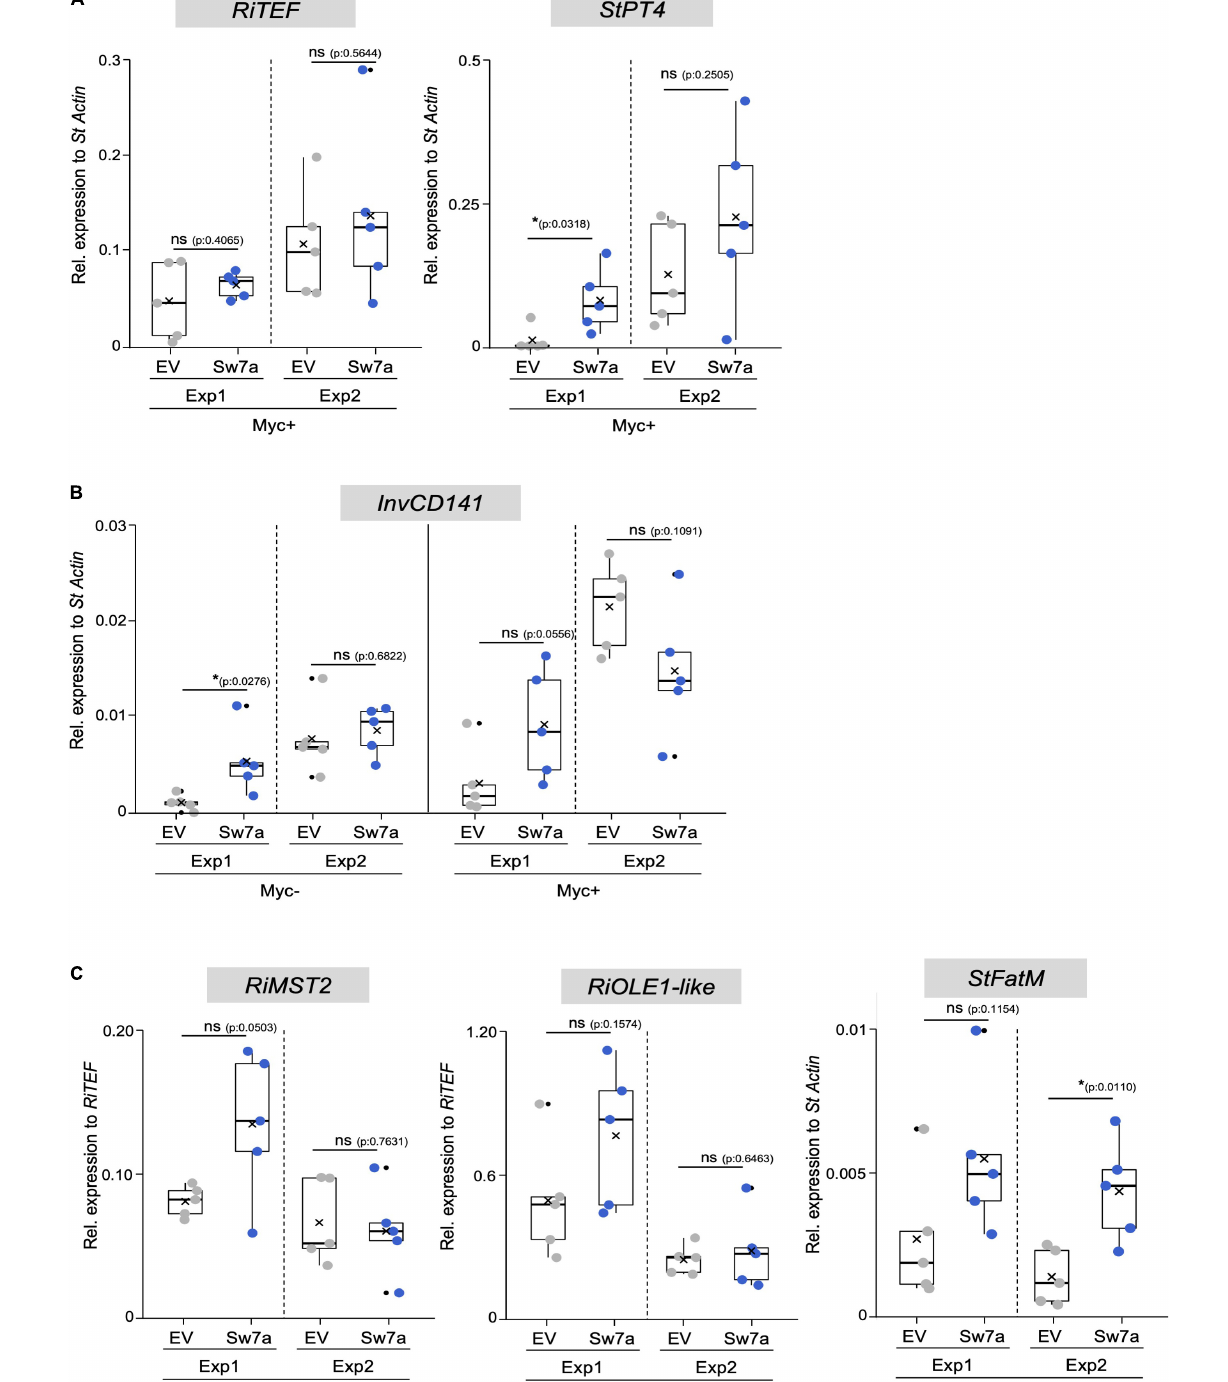
Frontiers in Plant Science |